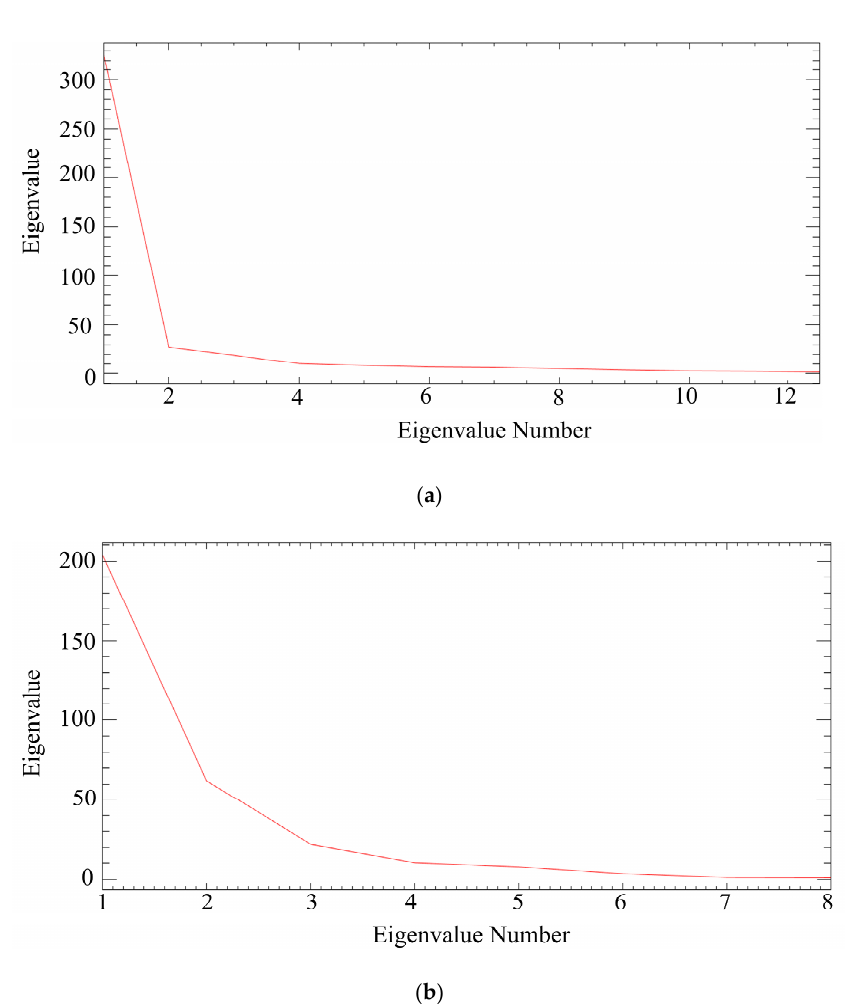
Figure 5. ( a ) The PCA transform eigenvalue curve of the Longkou area; ( b ) the PCA transform eigenvalue curve of the Honghu area.